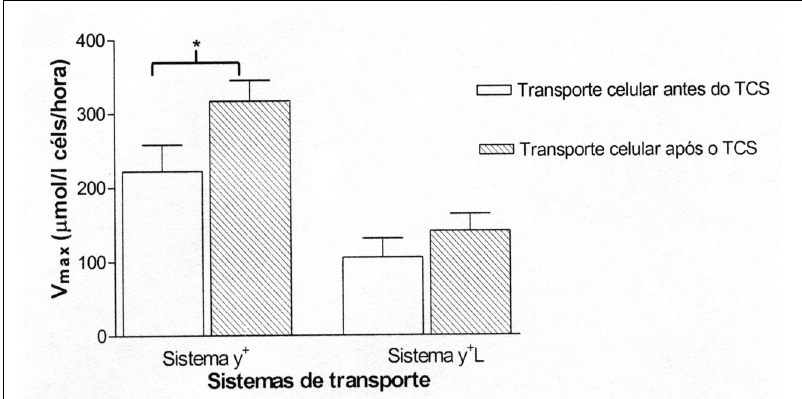
Figura 3 . Transporte celular de L-arginina pelos sistemas y + e y + L em hipertensas estressadas antes e após o Treino de Controle do Stress (TCS). Nota . * p <0.05.